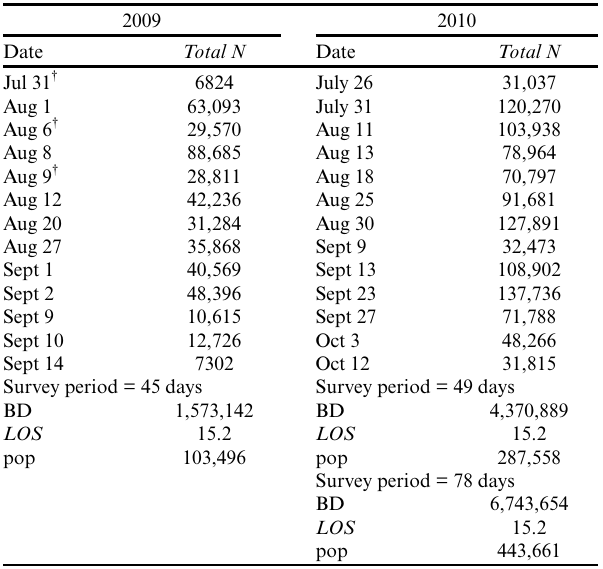
Table 3 . Combined abundance ( Total N ) of phalaropes in the study area by survey date, based on the sum of N by survey date in both Brier and Grand Manan. Results of numerical integration to find bird days (BD) and quantify stopover population size (pop) adjusting for length of stay are given. Estimated length of stay ( LOS ) was derived by fitting a probability density function to the observation times of radiomarked birds (n = 27) captured in 2008, 2009, and